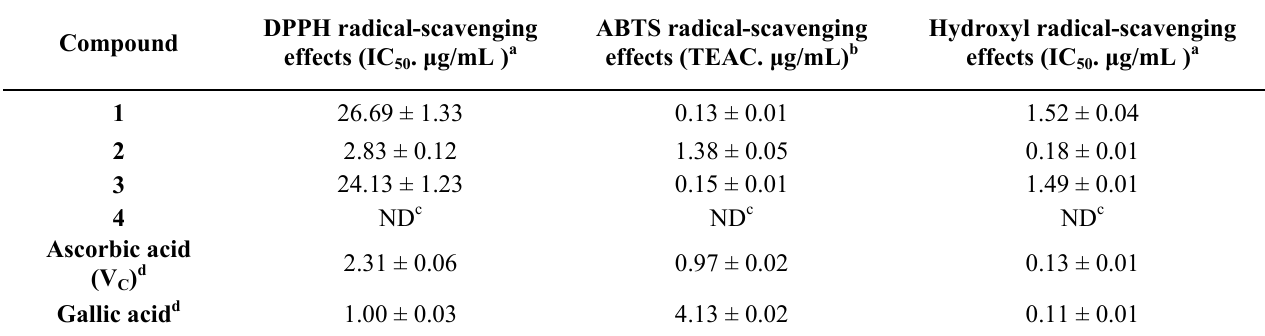
Table 1. In vitro antioxidant activities of the purified compounds (1-4) from Microcos paniculata.